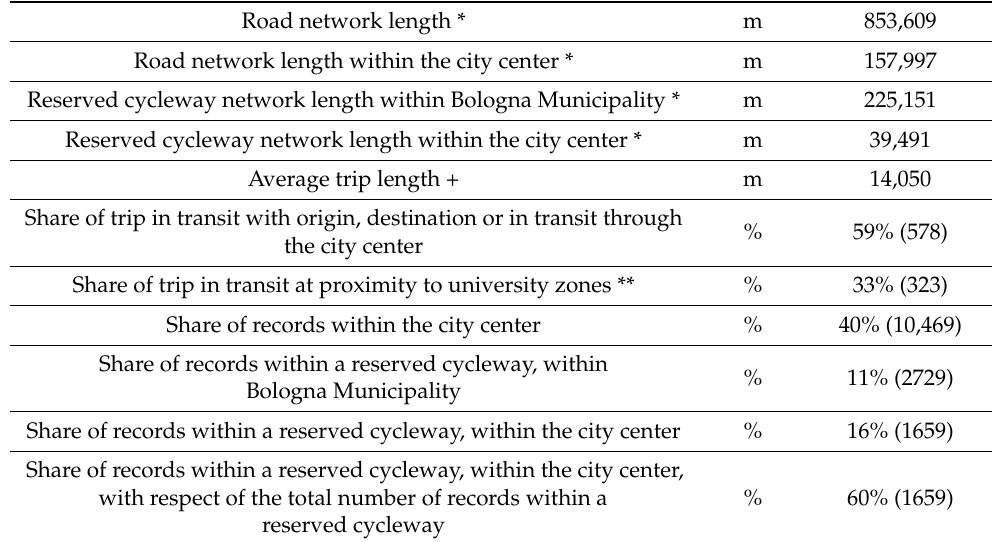
Table 2. Main parameters (+: The set of value comprises only the filtered trips. *: This value was obtained from the ESRI Shapefile. **: A fixed-distance buffer area (100 m) was calculated). Road network length * m 853,609 Road network length within the city center * m 157,997 Reserved cycleway network length within Bologna Municipality * m